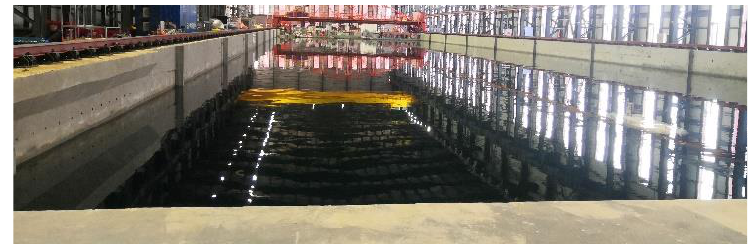
Figure 16. Photograph of the pool used in the study.